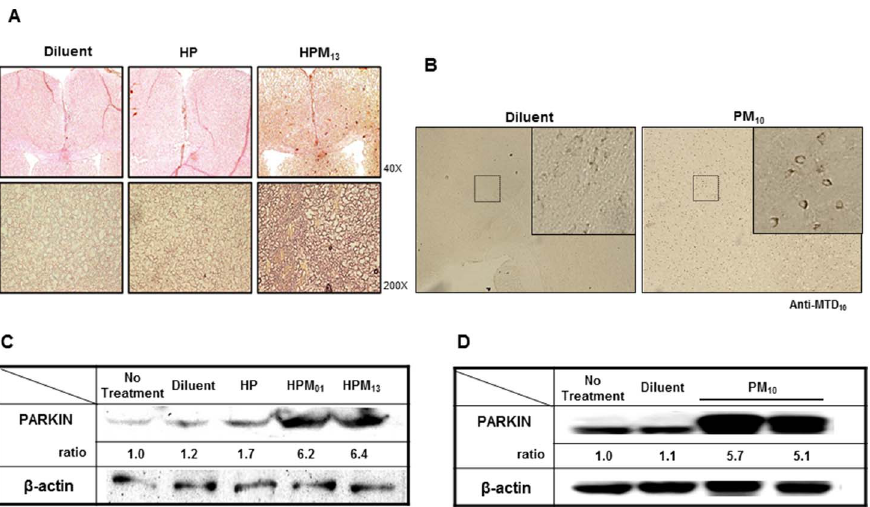
Figure 3. MTD-mediated parkin delivery to the brain. ( A–B ) Immunoblotting of parkin proteins in the cerebellum. Sagittal sections through the cerebellum were immunostatined with anti-parkin ( A ) or anti-MTD10 ( B ) antibody 2 hrs after IP injection of 200 m g of diluent alone or His-tagged parkin proteins without (HP) or with the MTD13 or MTD10 sequences (HPM 13 or PM 10 ) ( C–D ) Western blot analysis of brain parkin. Lysates were prepared from brain samples 2 hrs ( C ) and 30 hrs ( D ) after IV administration of diluent alone or 200 m g His-tagged parkin proteins without (HP) or with the MTD01 (HPM 01 ) or MTD13 (HPM 13 ) sequences ( C ) or with untagged parkin protein containing MTD10 (PM 10 ) ( D ) and analyzed by western blotting using anti-parkin and anti- b -actin